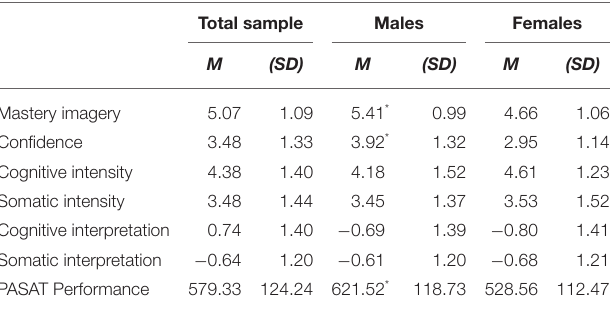
TABLE 1 | Total sample, male, and female mean ( M ), and standard deviation ( SD ) values for study